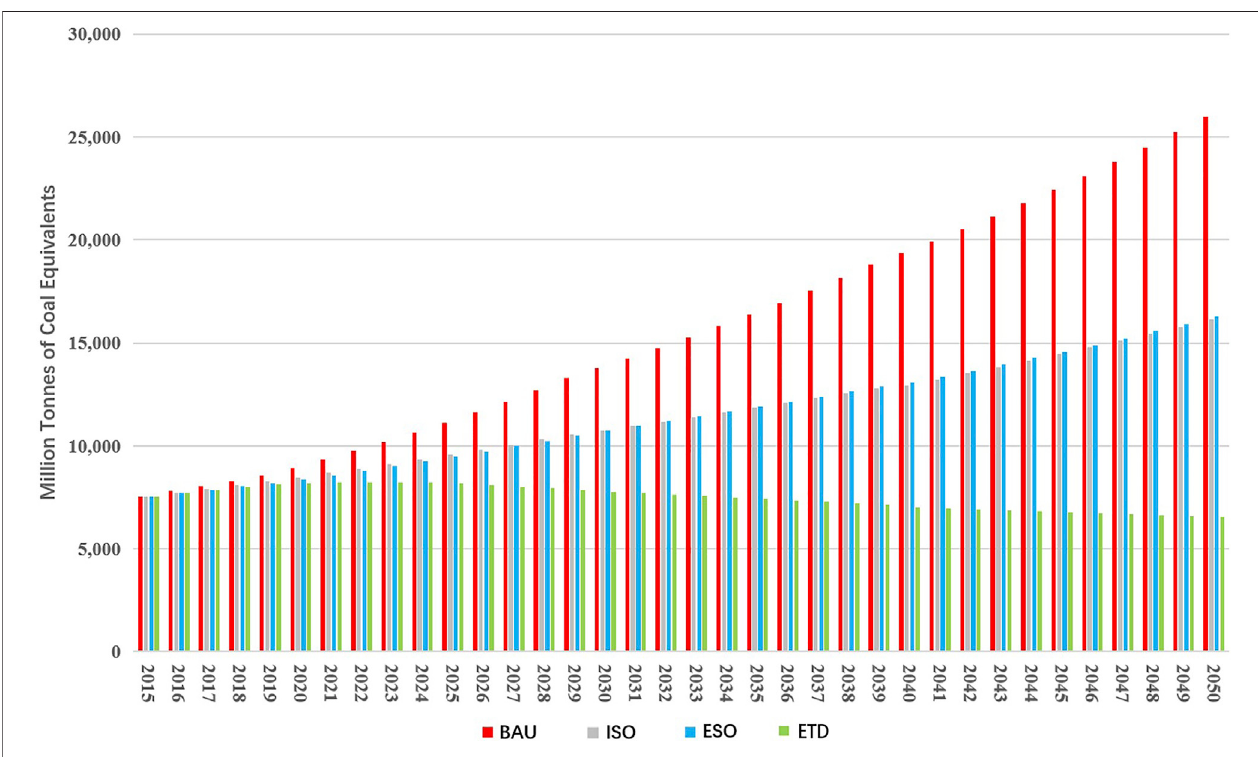
FIGURE 3 | Total energy demand trend of the different